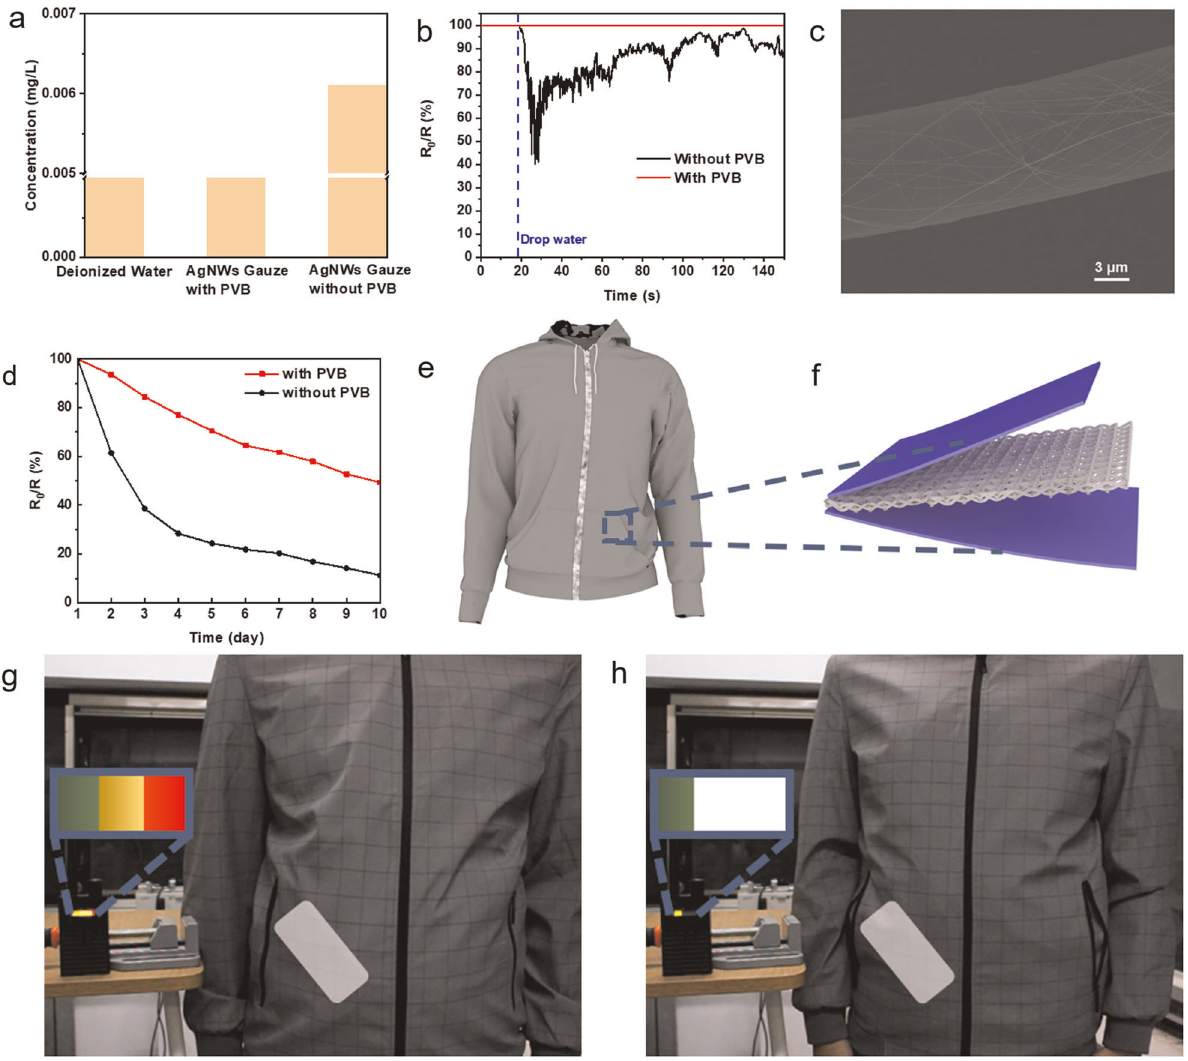
water. c SEM image of a single skeleton of AgNWs/PVB textile after washing with water. d The changes in the resistance of AgNWs/PVB textile and AgNWs textile in 60 °C hot air. e Schematic of a jacket with AgNWs/PVB textile and f the detail of every layer (the blues are the jacket shell fabric). A photograph with a magni fi cation of the signal bar of a mobile phone signal detector with the phone placed inside the jacket pocket lined with AgNWs/PVB textile ( g ) and without AgNWs/PVB textile ( h ) (grey square denotes the position of the mobile